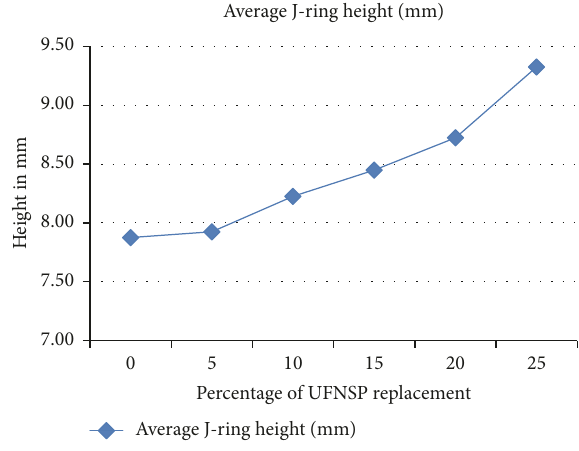
Figure 2: Results on J-ring test.